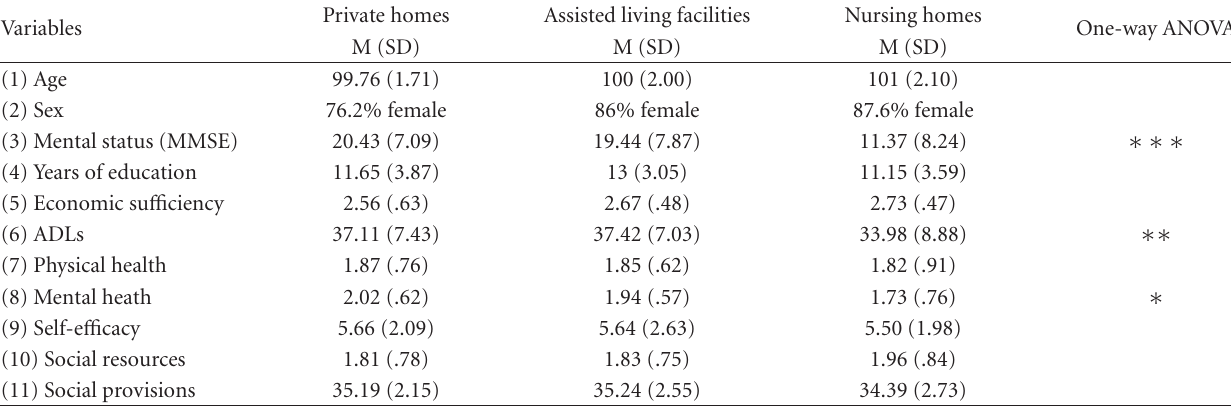
Table 1: Descriptives and ANOVA results for study